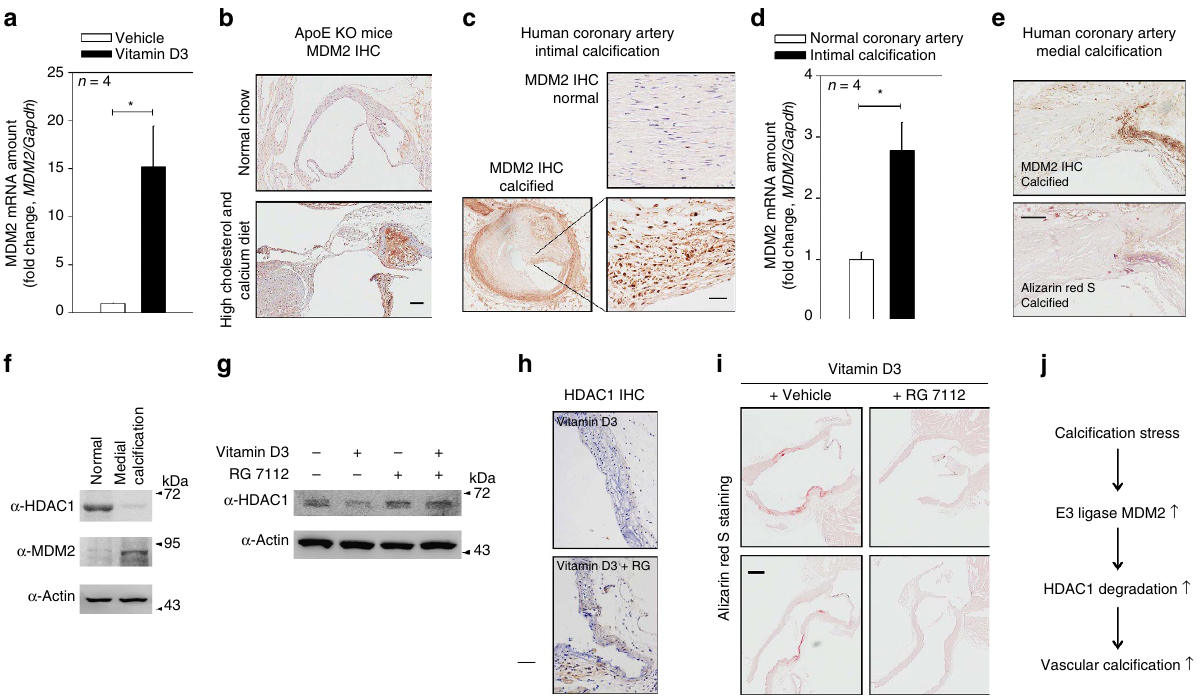
Figure 7 | MDM2 is upregulated in VC models and inhibition of MDM2 activity reduces VC in mice. ( a ) MDM2 mRNA level was upregulated in the aorta of VD 3 -administered mice (four mice from two sets). Each sample was measured in duplicate. ( b ) Immunohistochemical analysis showing MDM2 expression in ApoE mice fed high cholesterol and calcium as explained in Fig. 3f. Scale bar, 100 m m. ( c ) Immunohistochemical analysis showing that MDM2 expression is increased in the atherosclerosis-associated intimal calcification model of human coronary artery. The adjacent section slide was used with Fig. 3h. Scale bar, 50 m m. ( d ) Quantitative real-time RT–PCR results show that MDM2 mRNA level is significantly increased in the intimal calcification model of human coronary artery (four samples in duplicate). ( e ) MDM2 expression was increased at the site of calcification in human coronary artery with medial calcification in association with diabetes. Scale bar, 200 m m. (f) HDAC1 was downregulated, whereas MDM2 was upregulated, in human coronary artery sample with medial calcification. ( g ) Administration of RG (intraperitoneally, 50mgkg (cid:2) 1 per day, 9 days) prevented VD 3 -induced reduction of HDAC1 protein amount in mouse aorta. ( h ) Immunohistochemical analysis showing HDAC1 expression in VD 3 -treated mice. Note that nuclear expression of HDAC1 was restored by administration of RG. Scale bar, 50 m m. ( i ) Intraperitoneal administration of RG prevented VD 3 -induced VC in the ascending aorta. Scale bar, 250 m m. ( j ) Diagram of MDM2/HDAC1 signal cascade in VC. * P o